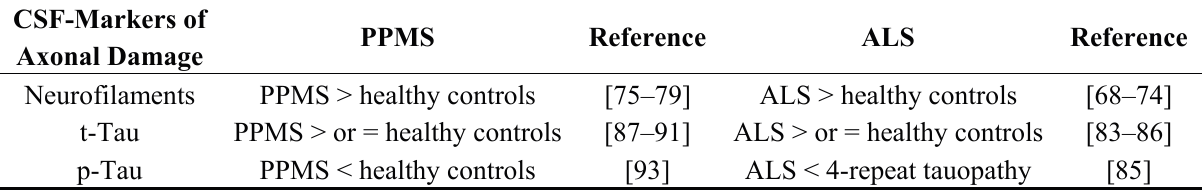
Table 5. Patterns of common CSF-Biomarkers of Axonal Damage: A comparison